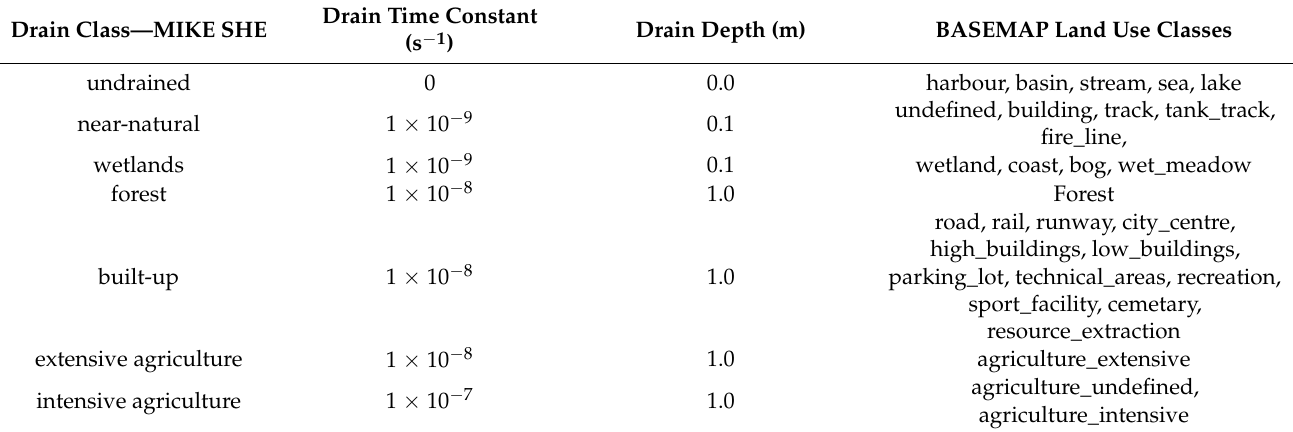
Table 2. Land-use-based drain classes (compare Figure 3) used in the MIKE SHE model setups with distributed drain parameterization. Drain time constants (ratios between them) and depths based on the national model